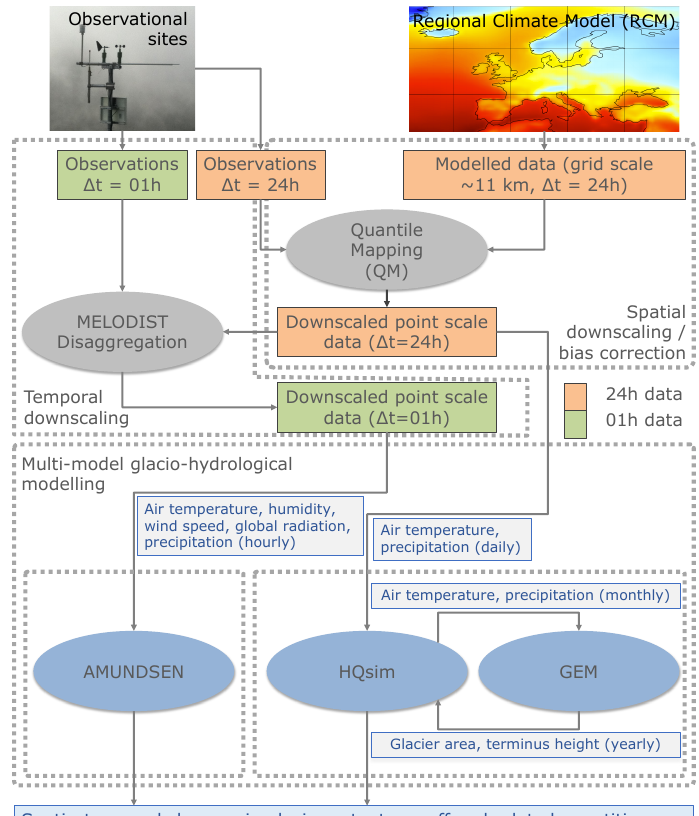
Figure 2. Flow chart of data and